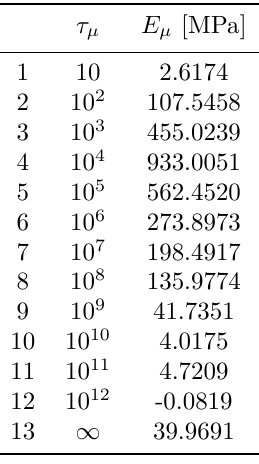
Table 1. Used values of Maxwell chain. Values con- verted from [5, Tables 1 and 2].